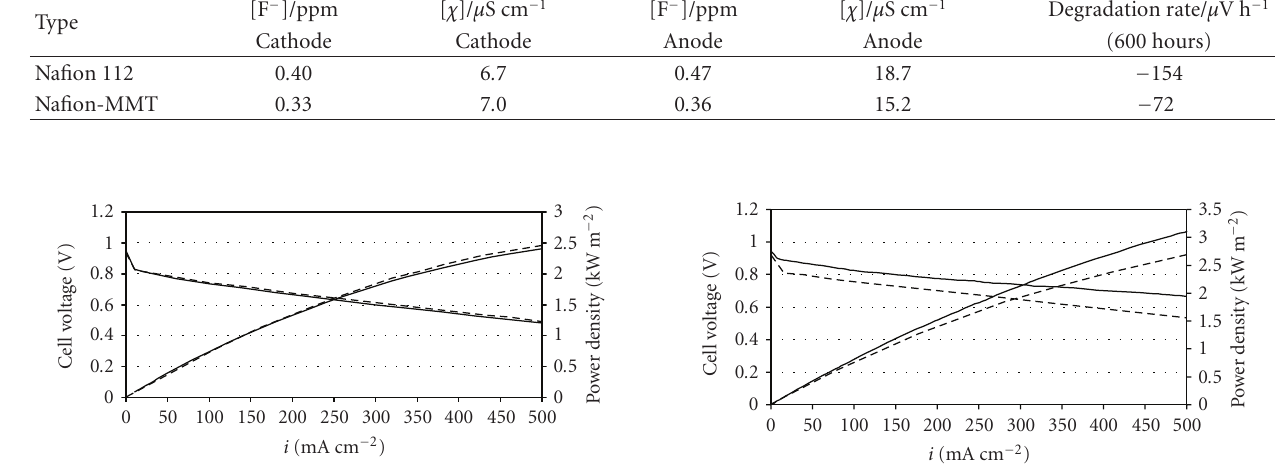
Figure 5: Cell voltage and power density versus current density plot for MEA with Nafion 112 (---) and Nafion/MMT ( bold continuous lines) at 50 ◦ C after the early 150 hours at low R.H.